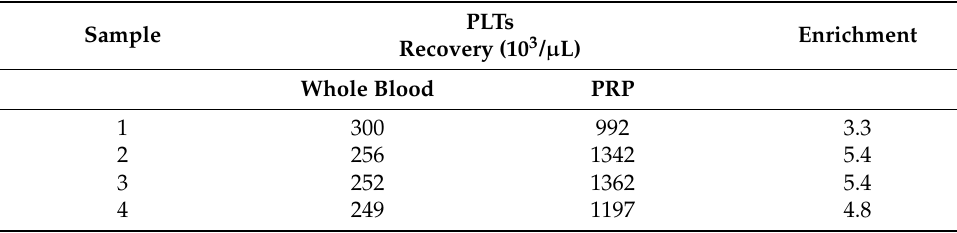
Table 1. PLTs count on donors’ whole blood and PRP units.